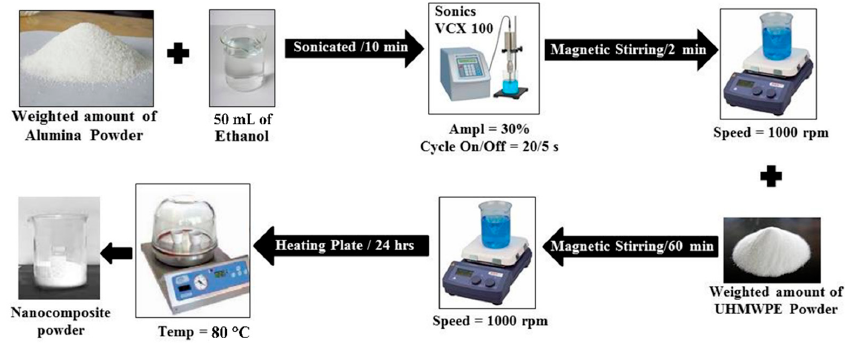
Figure 1. Flow chart describing the various steps in preparing the nanocomposite powders.